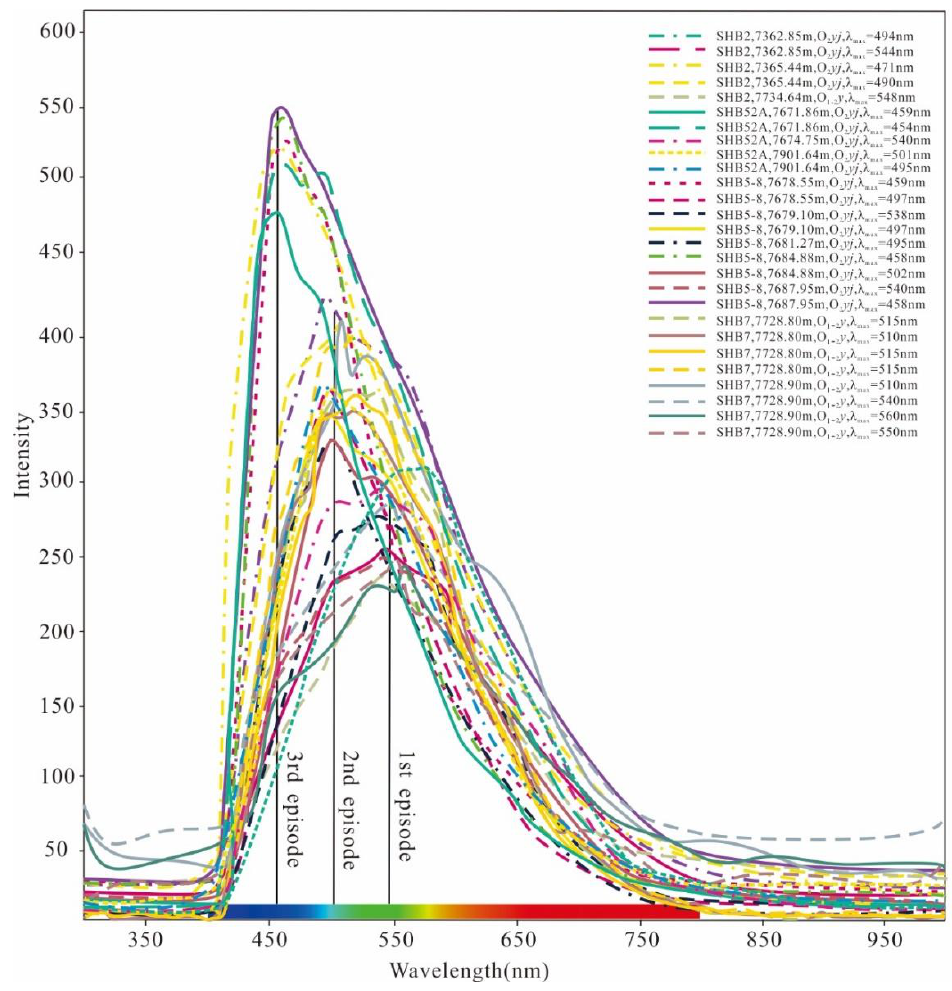
Figure 6. Microscopic fluorescence spectra from Ordovician oil inclusions in the Shunbei area.